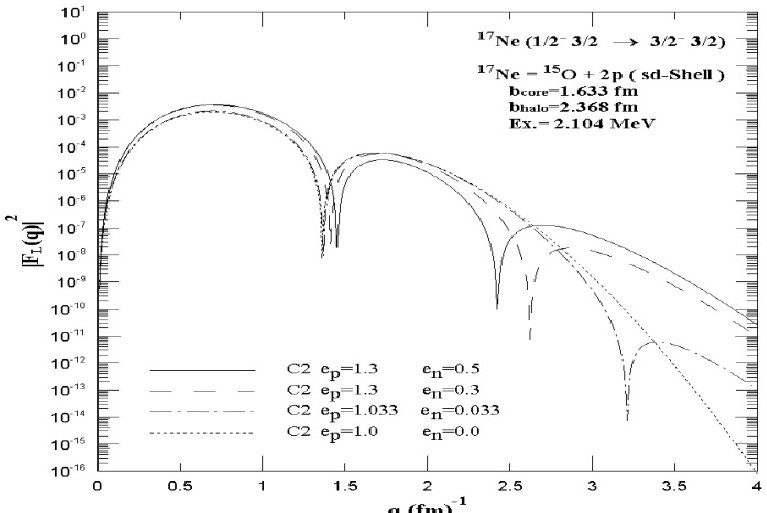
Fig. 6: The calculated inelastic longitudinal C2 form factors of 17 Ne with two protons in sd-shell and for ( 2323   TJ  )